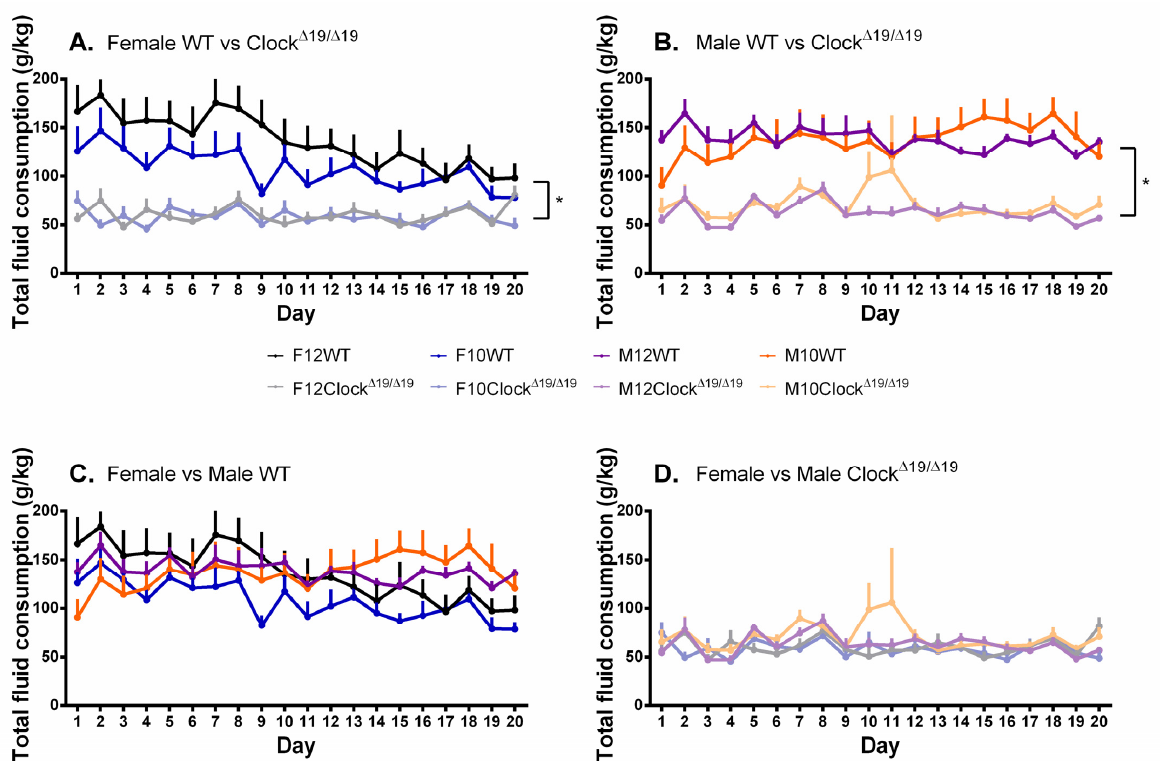
Figure 5. The total amount of fluids consumed by mice is influenced by sex, genotype, and number of drinking days, but not L:D cycle. ( A ). Female Clock ∆ 19/ ∆ 19 mice consumed less fluids in total compared to female WT mice, which demonstrated a decrease in the quantity of total fluids consumed across the 20-day testing period such that by the end of the study they were no longer different from female Clock ∆ 19/ ∆ 19 mice. ( B ). Compared to male WT mice, male Clock ∆ 19/ ∆ 19 mice demonstrated reduced amounts of total fluids consumed, an effect that was maintained throughout the duration of the study. ( C ). Female and male WT mice initially demonstrated similar amounts of total fluids consumed; toward the end of the study, female WT mice were consuming slightly less than male WT mice. ( D ). Female and male Clock ∆ 19/ ∆ 19 mice demonstrated similar amounts of total fluids consumed across the 20-day testing period. F = females, M = males; 12 = 12:12 L:D cycle, 10 = 10:10 L:D cycle; WT = wild-type. Darker tones are WT mice and lighter tones are Clock ∆ 19/ ∆ 19 mice. Black = female 12:12 L:D group, blue = female 10:10 L:D group, purple = male 12:12 L:D group, orange = male 10:10 L:D group. * = p <